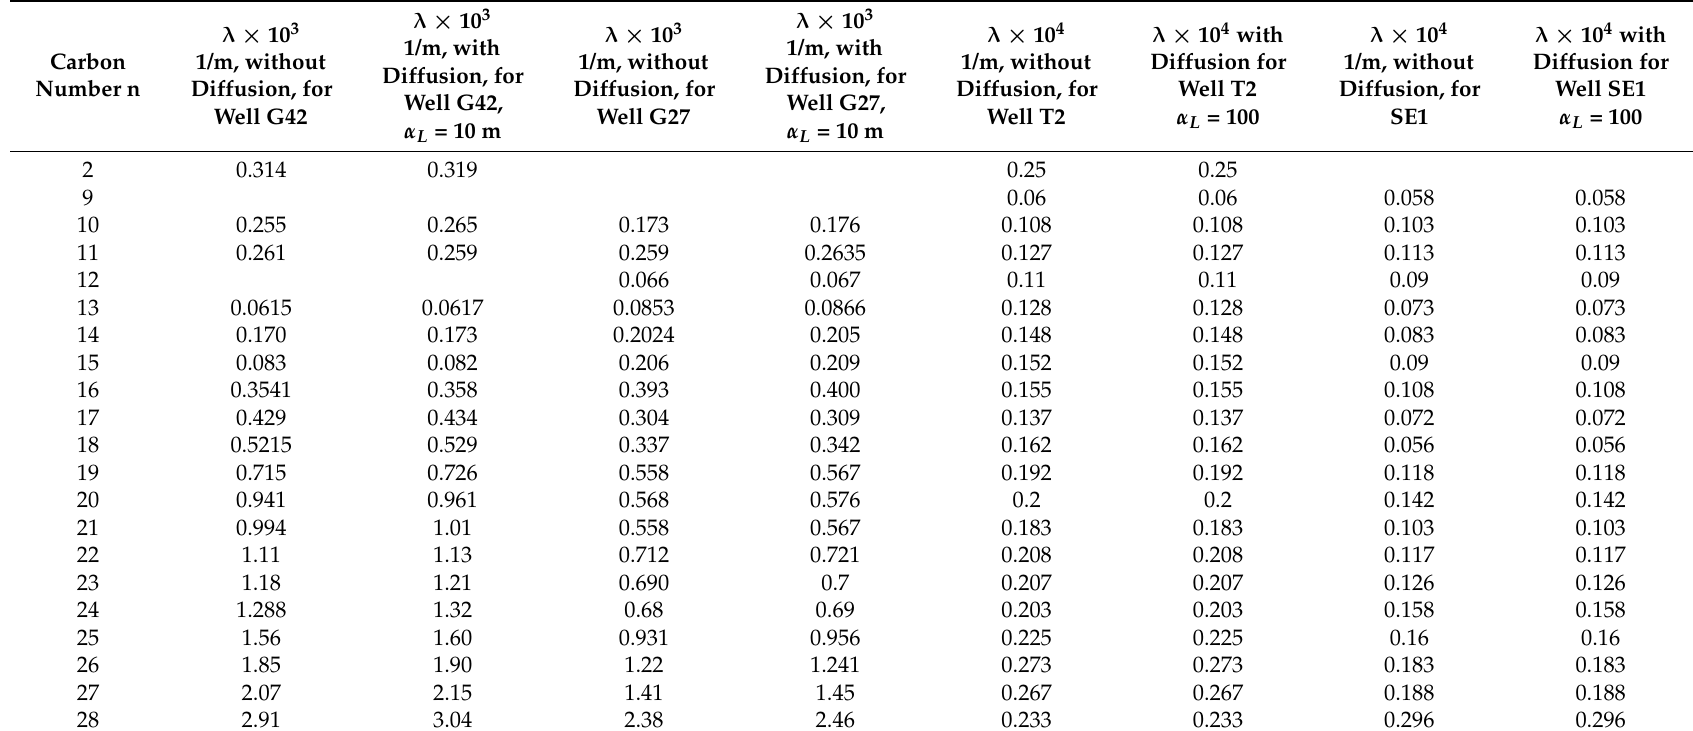
Table 1. Results of concentration data treatment for four